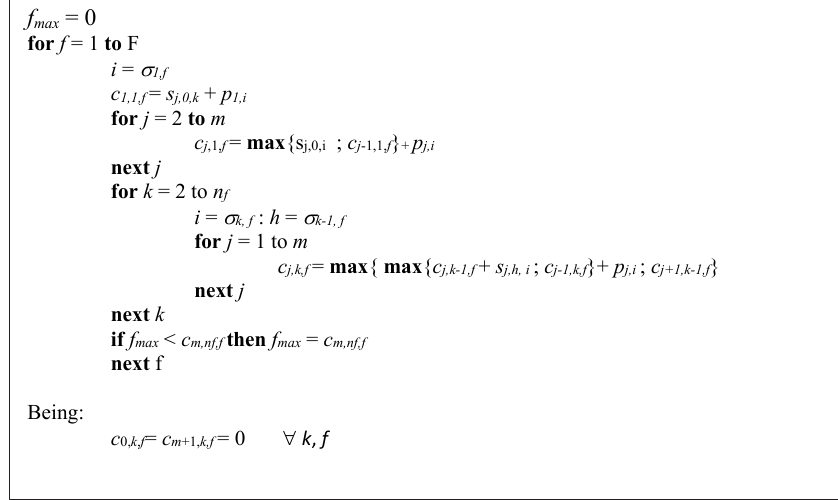
Fig. 1. Outline of makespan